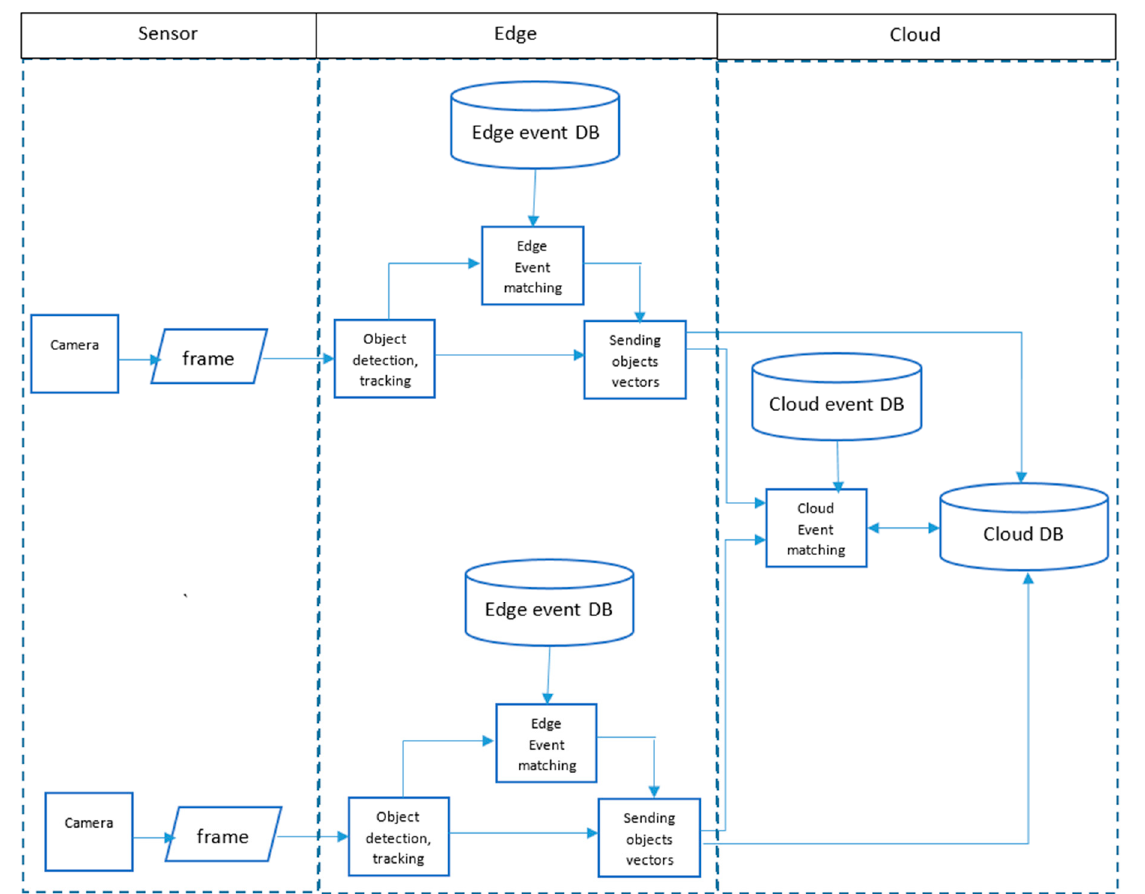
Figure 1. The designed integrated architecture for complex event detection (DB: DataBase).